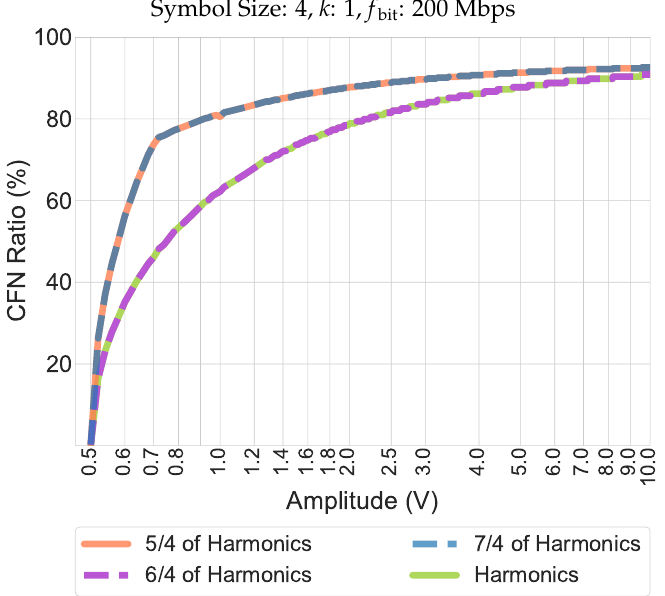
Figure 7. Increasing trend of CFN ratio at specific fractions of the disturbance frequency